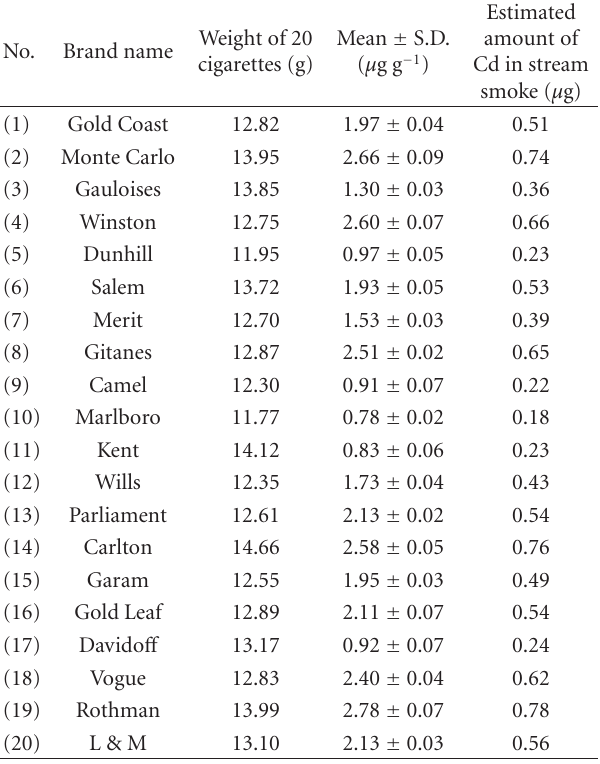
Table 2: The weight of 20 cigarettes (g) concentration of Cd in µ gg − 1 (dry weight) and average estimated amount of Pb passed to main stream smoke for 20 cigarettes a day in 20 di ff erent cigarette brands. a